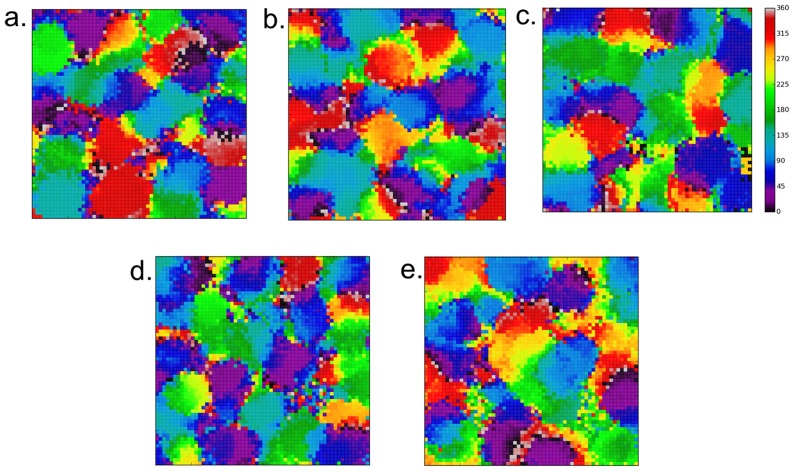
Direction Preference maps for different LGN afferent connectivity conditions.The figures in the top row show the effects of varying the LGN-Cortical connection field size on the arrangement of cortical responses. The cases are a) 3×3 connection field b) 5×5 connection field c) 7×7 connection field d) Random connectivity between the LGN and Cortical layers and e) LGN and Cortical layers fully connected. The characteristic distributed patches of activity in response to different patterns are present in all maps (although there are differences in the neuron selectivity see Table 3). Figures 7b (standard case CF 5×5; the same map as Fig 4) and 7c (CF 7×7) show best similarity to experimental maps, whilst 7d and 7e have much less smooth transitions of preference and bigger areas of uncertain preference (speckled patches).